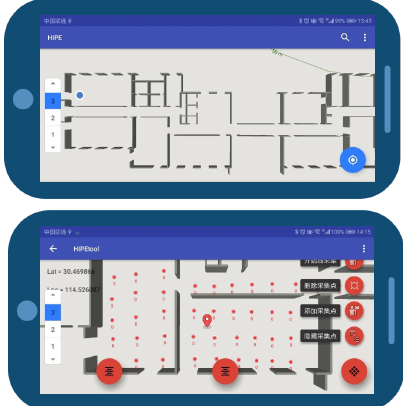
Figure 11. Screenshots of HIPE application: the top panel denotes the online localization, and the bottom panel denotes the construction of radio